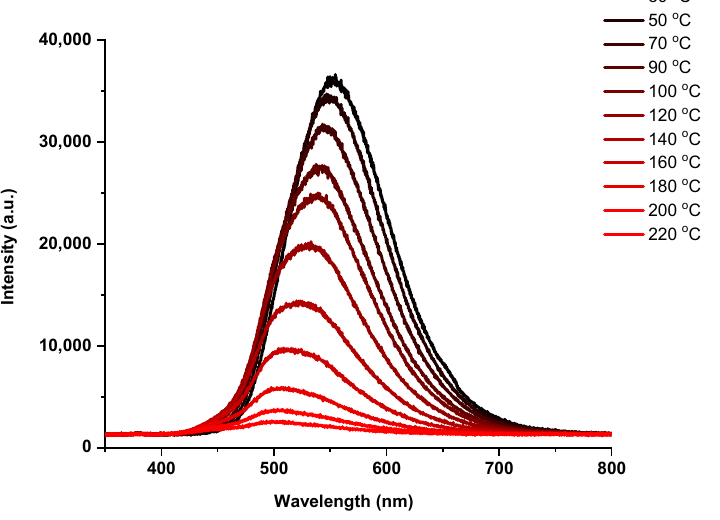
Figure 29. Emission spectra of polymer 3 a in the solid state at different temperatures.